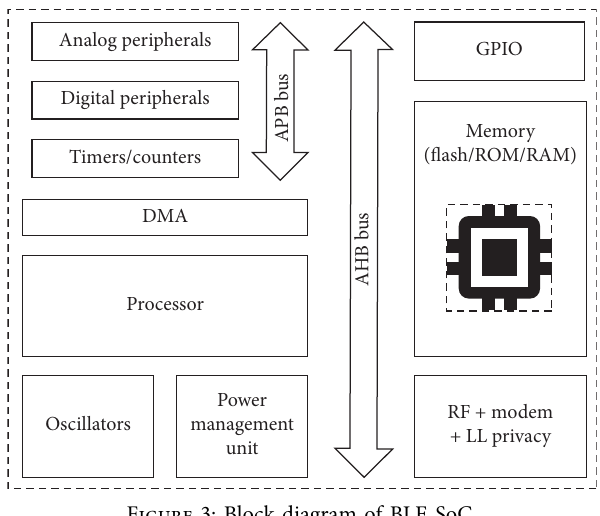
Figure 3: Block diagram of BLE SoC.